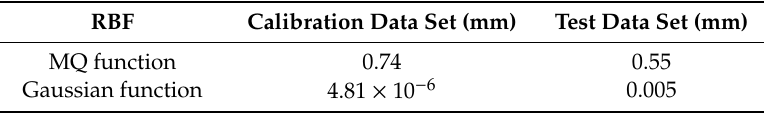
Table 4. Comparison with di ff erent RBFs.